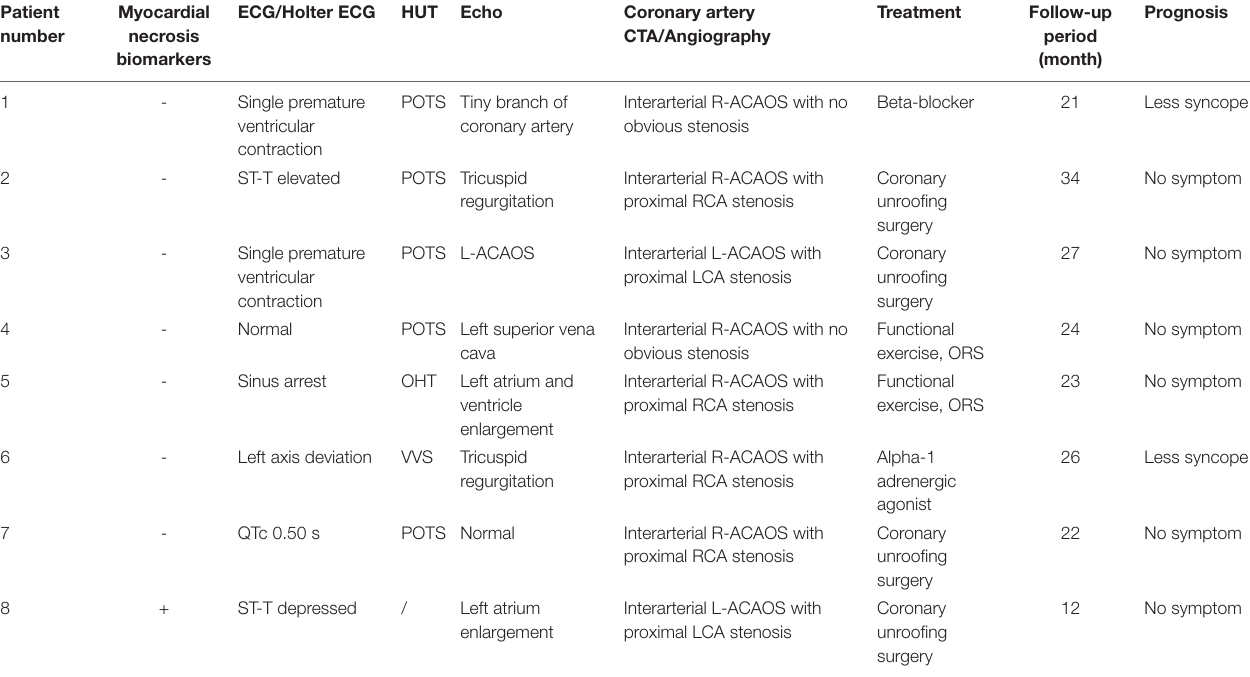
TABLE 2 | Laboratory and imaging findings, treatment, and